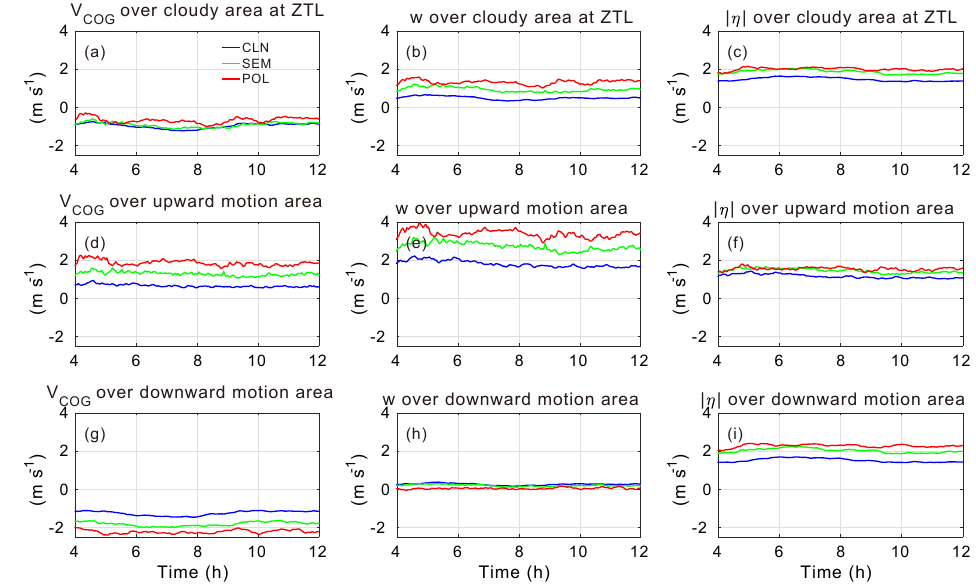
Figure 8. Time series of (a) mean COG velocity ( V COG ), (b) air vertical velocity ( w ), and (c) effective terminal velocity ( | η | ) weighted by mass over a cloudy region at the ZTL; panels (d–f) and (g–i) are similar to panels (a–c) , but averaged over positive and negative V COG regions,